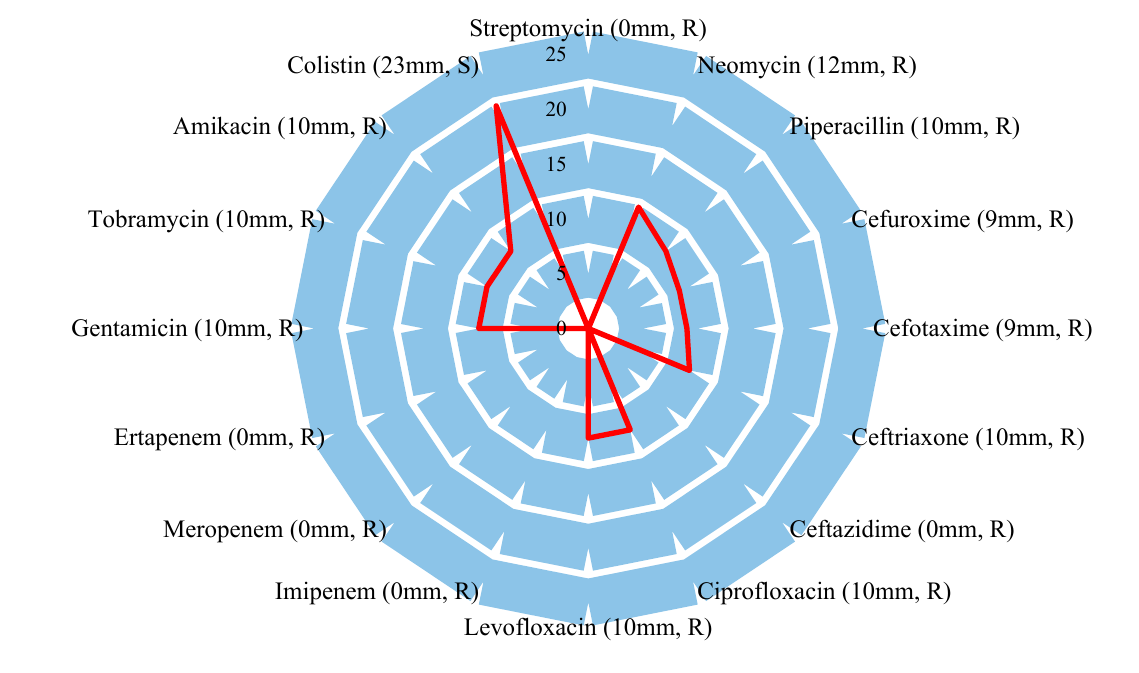
Figure 1. Radar plot showing the antibiotic resistance profile of P. aeruginosa strain B10. R = resistant, S = sensitive. The size of the inhibition zone is presented in mm; 0 mm indicates no inhibition zone detected (i.e., the tested bacterium was not sensitive to the respective antibiotic).